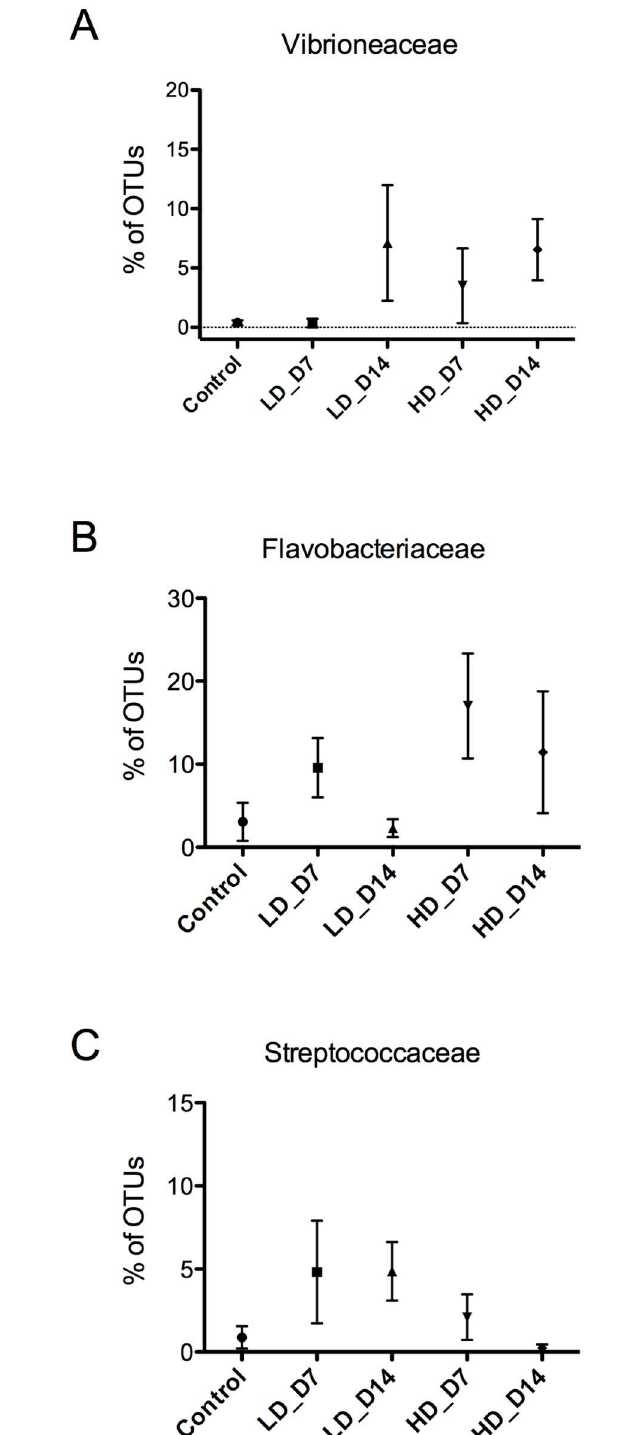
Fig 6. SAV3 infection results in increased abundance of opportunistic pathogens. Percentageof total OTUs respresented by Vibrionaceae (A), Flavobacteriaceae (B) and Streptococcaceae (C) in control and SAV-infected groups. The P values obtainedin the statistical analysisare shown in Table 2. LD_D7: low-dose infected day 7; LD_D14:low-doseinfected day 14; HD_D7: high-dose infected day 7; HD_D14:high-dose infected day